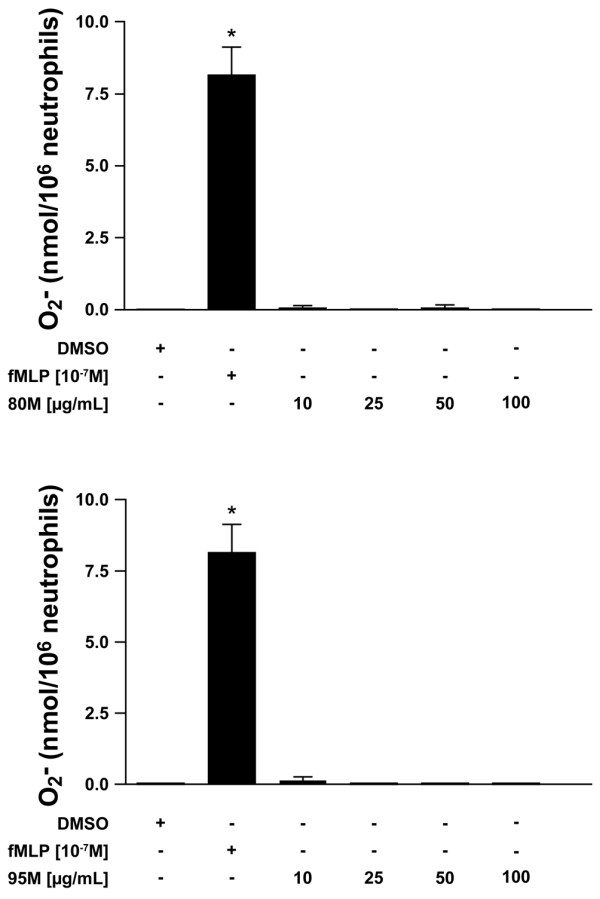
Production of superoxide anions by PMN in response to chitosan. Superoxide anion production was determined using the cytochrome c reduction assay. Freshly isolated polymorphonuclear neutrophils (PMNs) resuspended in RPMI 1640 supplemented with 0.1% decomplemented fetal bovine serum were incubated with the indicated concentrations of 80% deacetylated (80 M) or 95% deacetylated (95 M) chitosan for 10 minutes at 37°C. Results are presented as mean ± standard error. The difference from the negative control is statistically significant: *P < 0.001 (Tukey-Kramer test). The negative control = PMNs incubated in Hanks' Balanced Salt Solution supplemented with 0.1% decomplemented fetal bovine serum and incubated with diluent (dimethyl sulfoxide [DMSO]). This figure represents the results of at least three independent experiments. fMLP, N-formyl-methionyl-leucyl-phenylalanine.